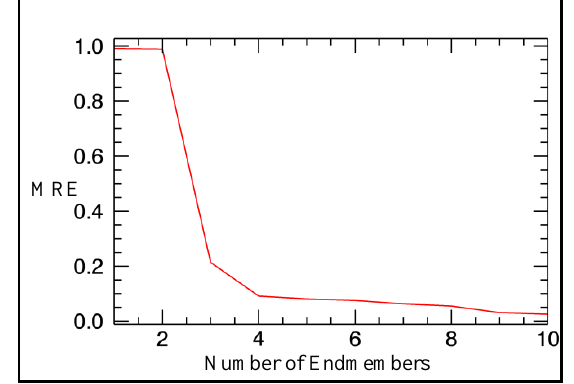
Figure 6. SMACC output showing the relationship between the number of identified endmembers and the maximum relative error (MRE). The SMACC algorithm ends when either the MRE drops below a given threshold or a certain number of endmembers are found.